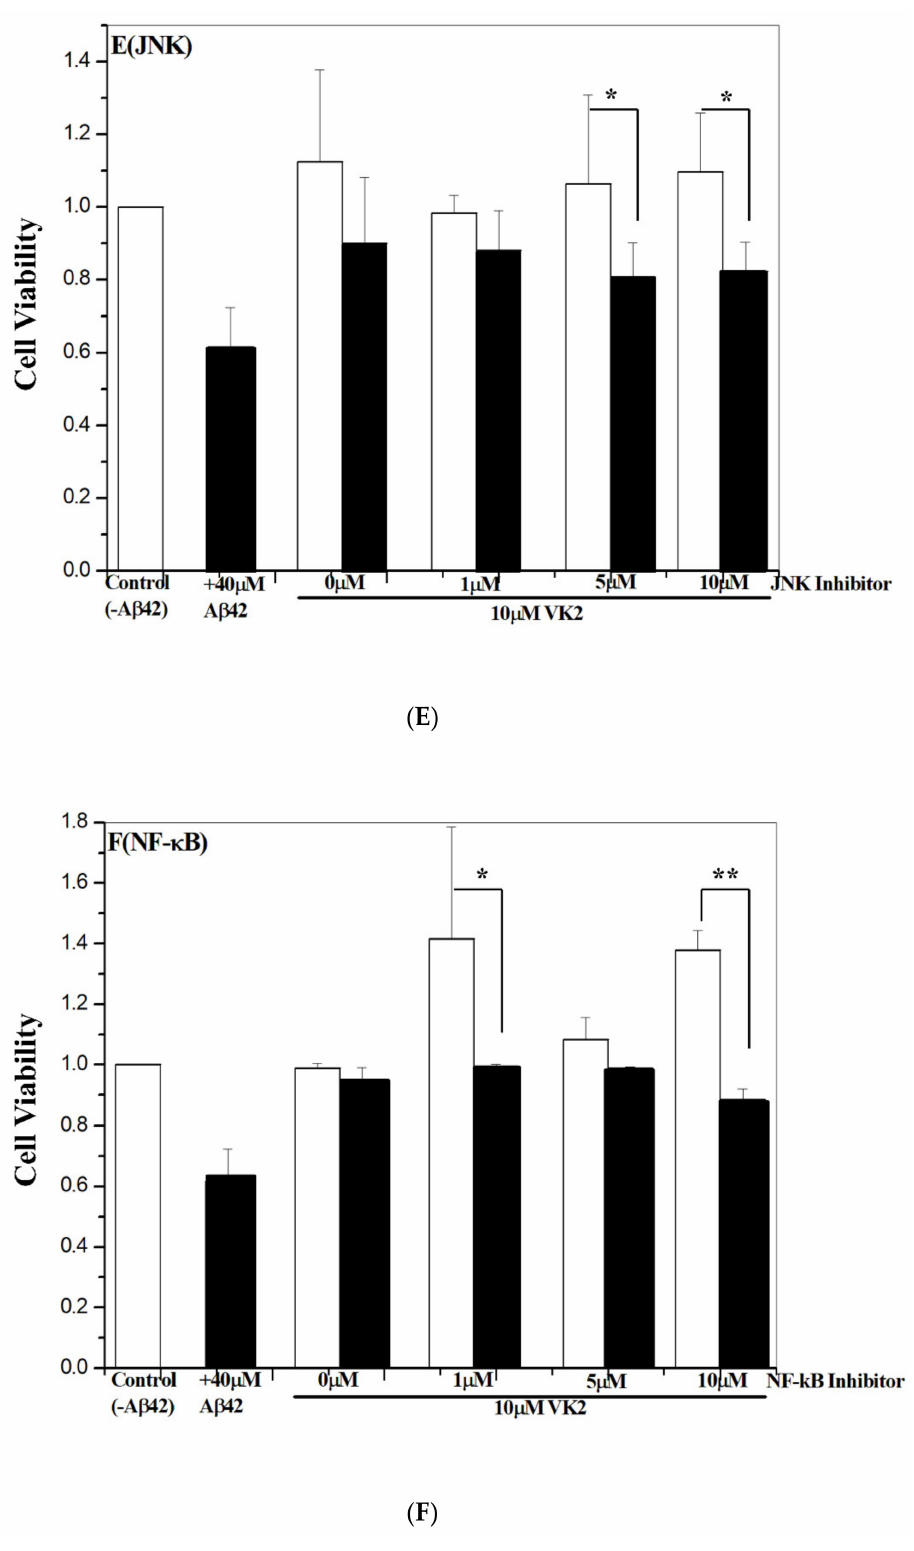
Figure 4. Effect of various-signaling pathway inhibitors on vitamin K2-dependent protection. Primary neurons were incubated for 72 h with 250 µ g cumate, 10 µ M vitamin K2 (VK2) and inhibitors for ( A ) ERK, ( B ) PI3K, ( C ) Akt, ( D ) p38- SAPK, ( E ) JNK and ( F ) Nf- κ b, respectively. The cell survival rate was determined by MTT assay. Data are means ± SD. * p < 0.05 and ** p <